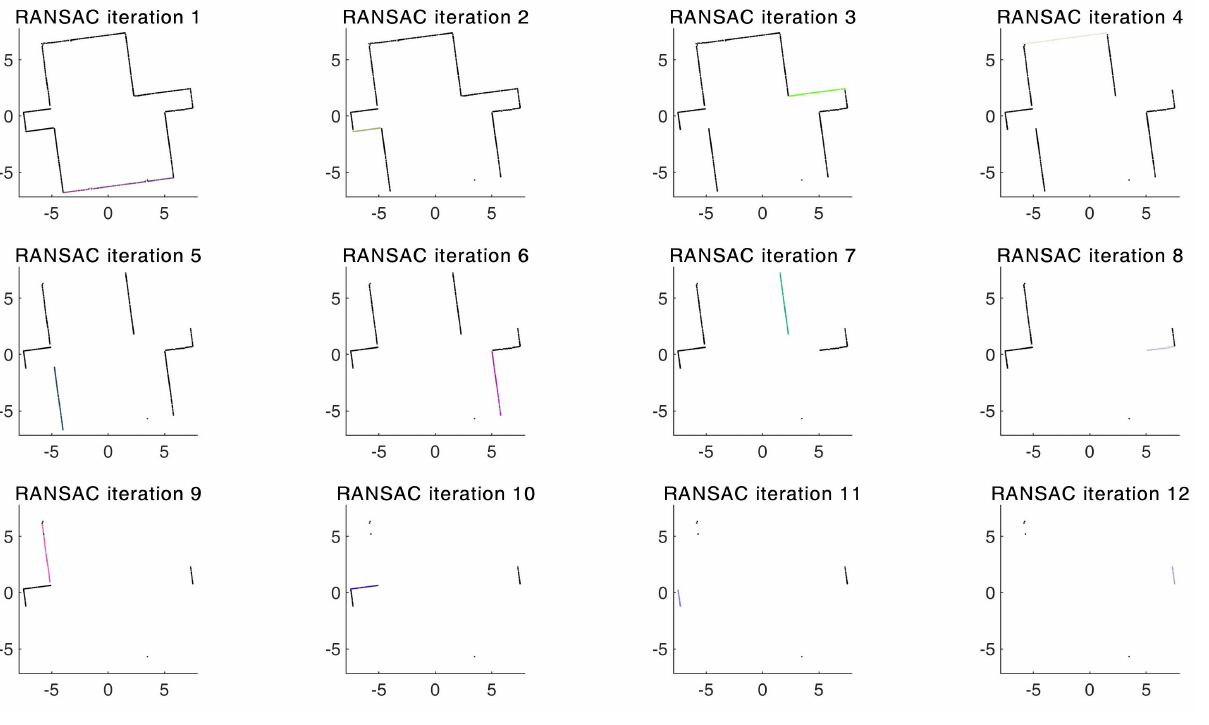
Figure 13: RANSAC iterations for identifying the sides of the room.